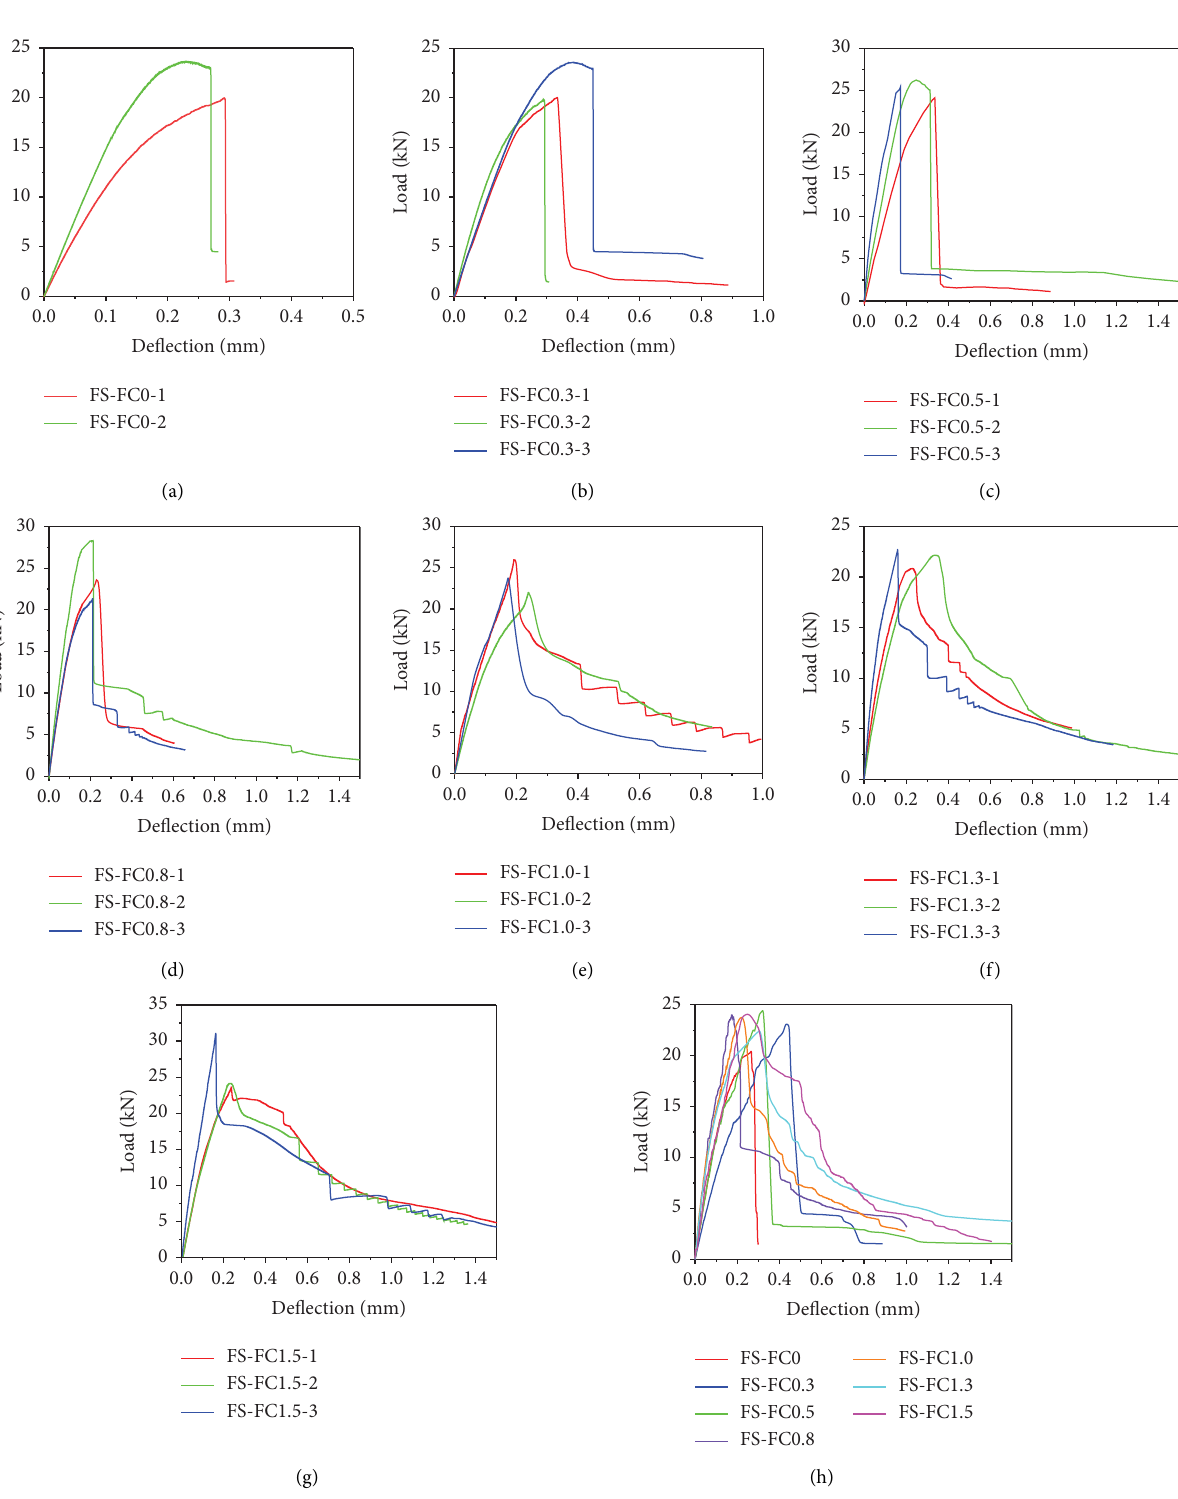
Figure 7: ARGFRC fexural load-defection curve: (a) FS-FC0; (b) FS-FC0.3; (c) FS-FC0.5; (d) FS-FC0.8; (e) FS-FC1.0; (f) FS-FC1.3; (g) FS- FC1.5; and (h) comparison